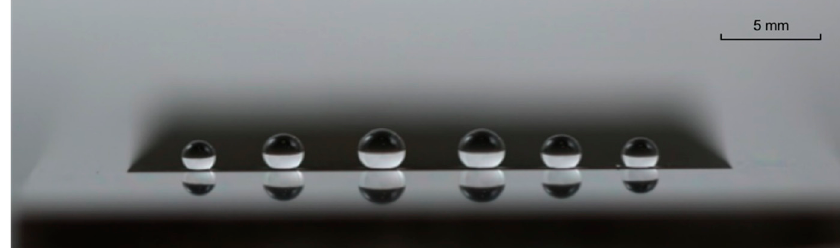
Figure 2. Water droplets rolled to the edge of the sample, exhibiting uniform superhydrophobic properties across a 3 × 3 cm structured metal surface.